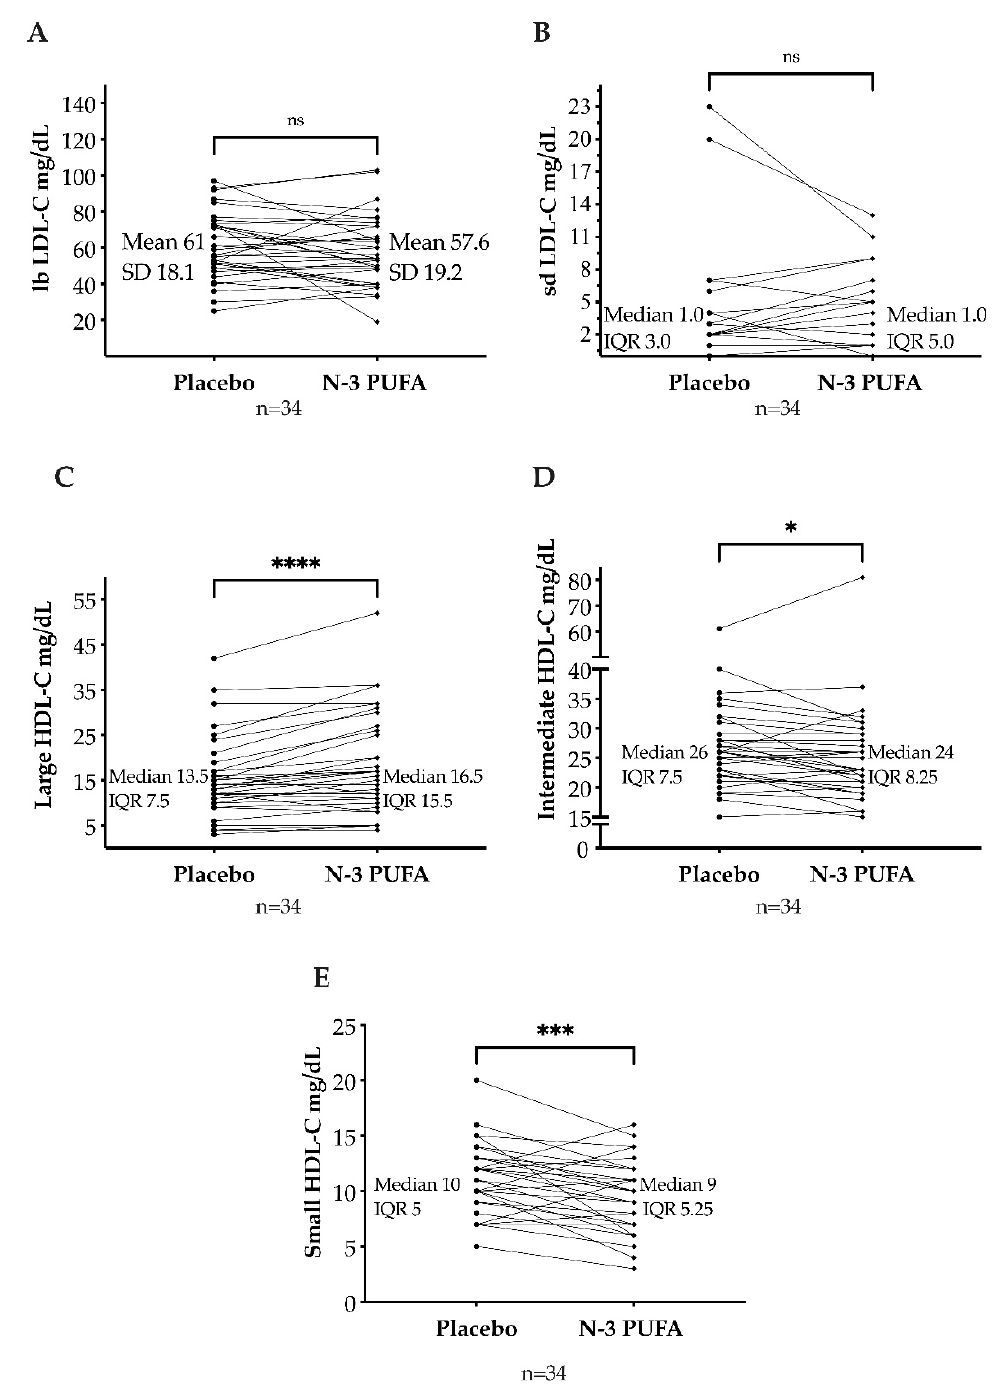
Figure 4. Large, buoyant low-density lipoprotein cholesterol (lbLDL-C) ( A ) and small, dense low- density lipoprotein cholesterol (sdLDL-C) ( B ) after omega-3 polyunsaturated fatty acids (n-3 PUFAs) and placebo. Large high-density lipoprotein cholesterol (large HDL-C) ( C ), intermediate HDL-C ( D ), and small HDL-C ( E ) after n-3 PUFAs and placebo. SD: standard deviation. IQR: interquartile range. ns = p > 0.05; * = p ≤ 0.05 *** = p ≤ 0.001; **** = p ≤ 0.0001.